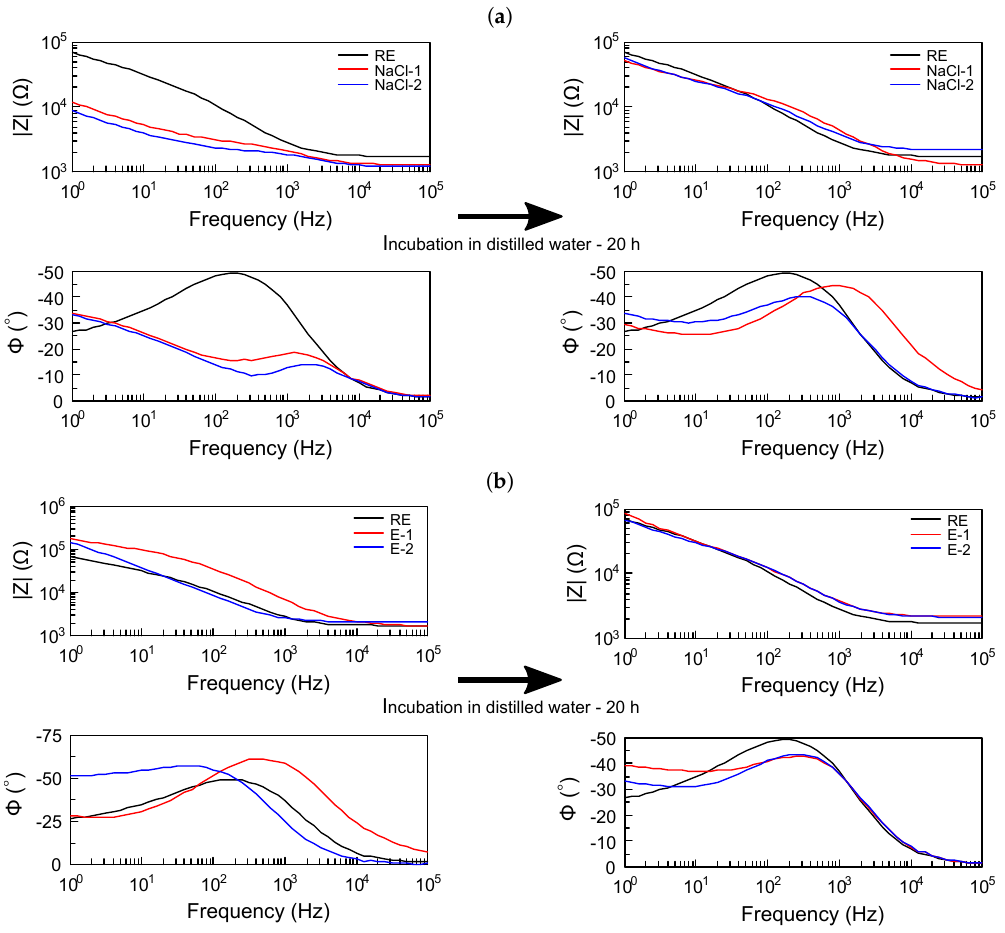
Figure 7. Bode plots for samples used as RE after ( a ) modification in NaCl solution and ( b ) electrolysis, where RE—commercial Ag/AgCl RE, NaCl-1 and NaCl-2—sample of Ag/AgCl RE formed in highly concentrated NaCl, E-1 and E-2—sample of Ag/AgCl RE formed using